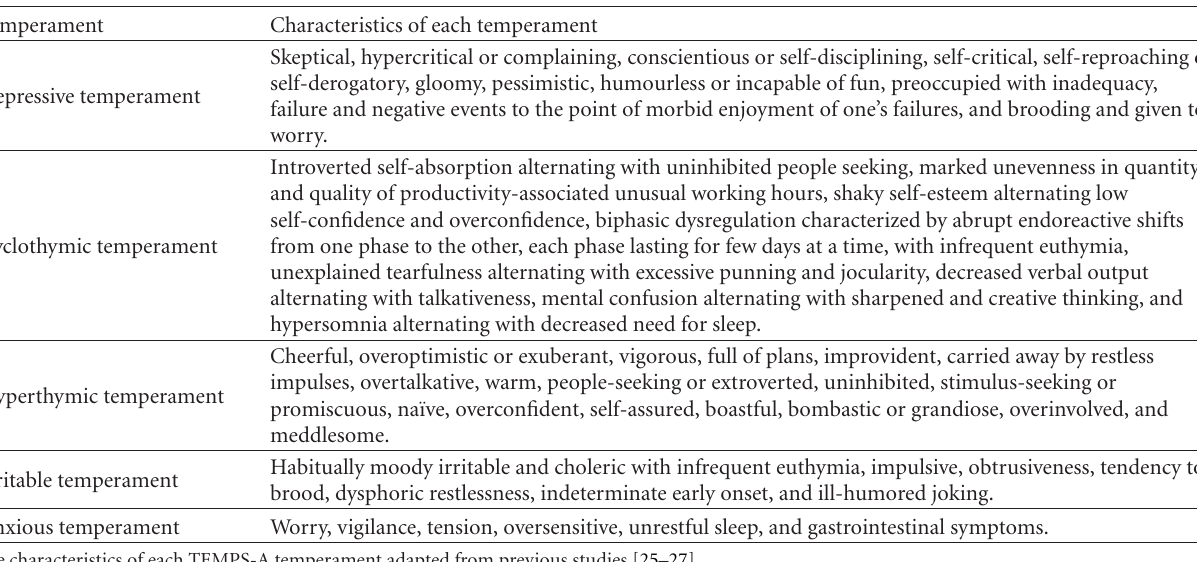
Table 6: Characteristics of each